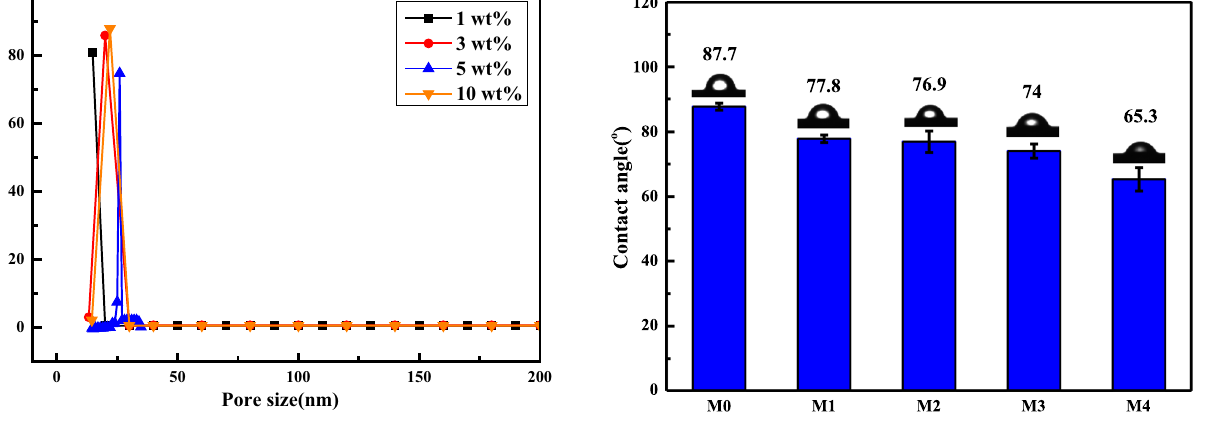
Fig.7 Pore size distribution of PVDF flat sheet membrane with differ- ent PVP content